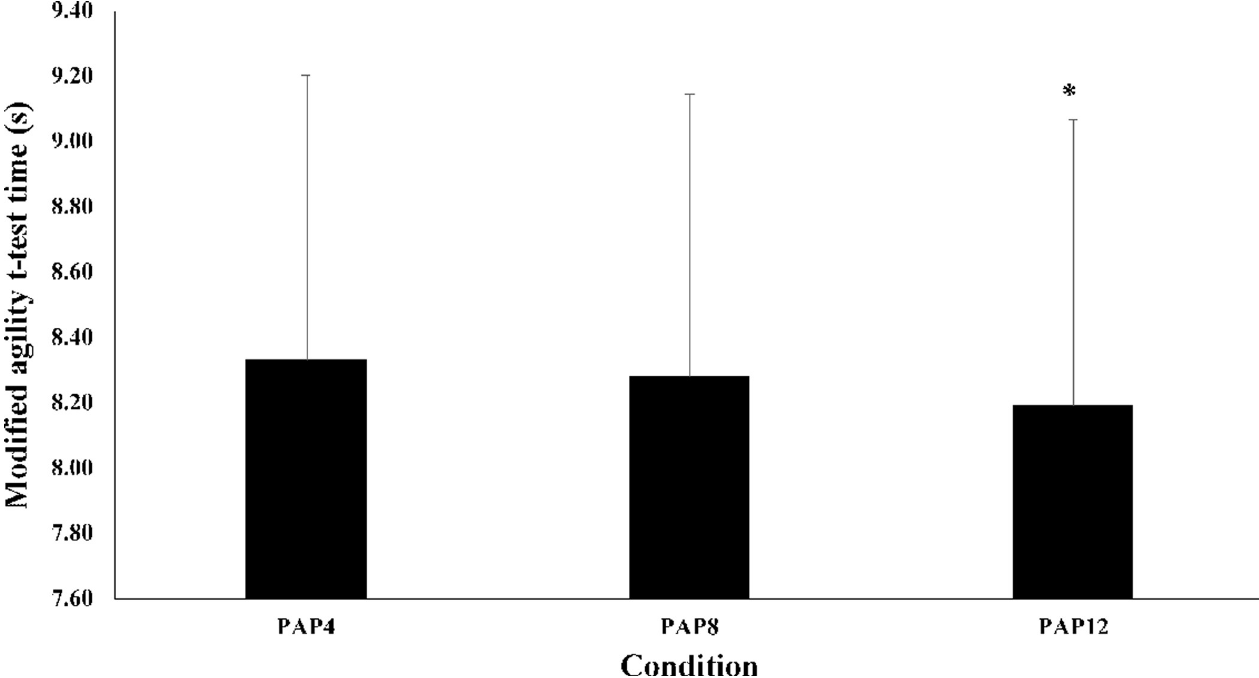
Fig 4. Mean ± SD for modified agility t-test times (s) for the PAP4, PAP8 and PAP12 conditions. � Denotes a statistical significance compared to other conditions (P < 0.0005).